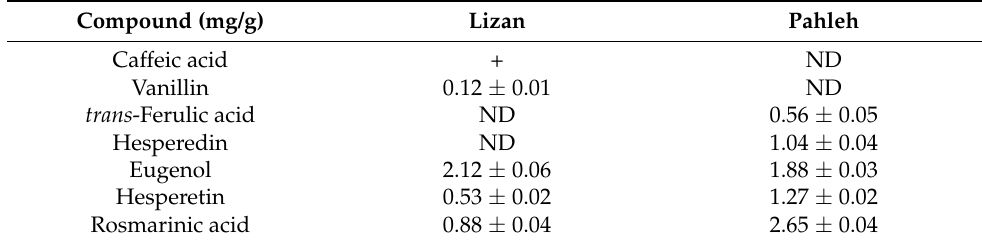
Table 1. Polyphenol profile, as determined by HPLC in the two Scrophularia striata